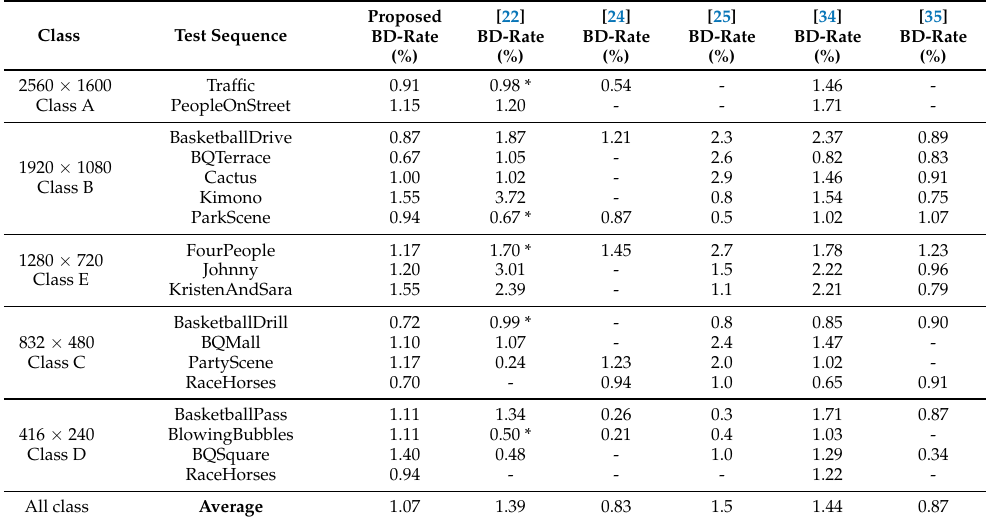
Table 7. The BDBR of the proposed method compared with the anchor method and previous works.